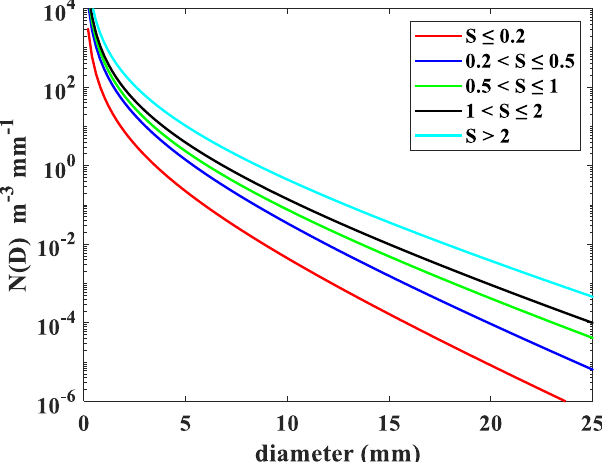
Table 4. Mean values of 𝐷 𝑚 , 𝑙𝑜𝑔 10 𝑁 𝑤 , and 𝜇 for different snow rate classes